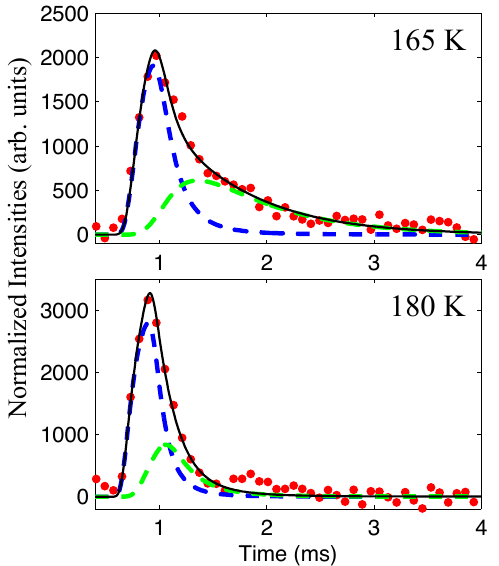
Fig. 4. Time-of-flight distributions for D 2 O scattering and desorb- ing from butanol covered ice surfaces. The black, blue, and green curves show the total, inelastic, and thermal desorption components of the non-linear fitting described in the text, and overlie a three- point smoothing of the data.